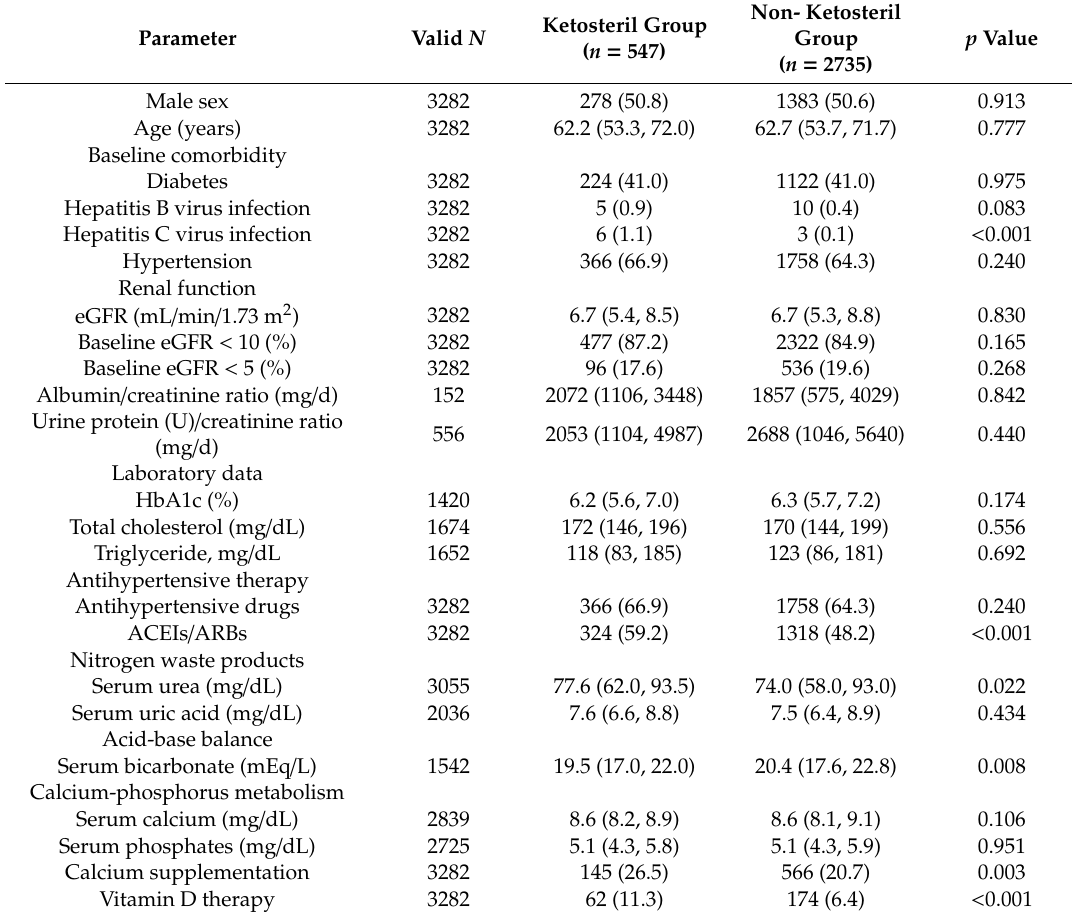
Table 1. Baseline characteristics of patients with advanced CKD in the Ketosteril and non-Ketosteril